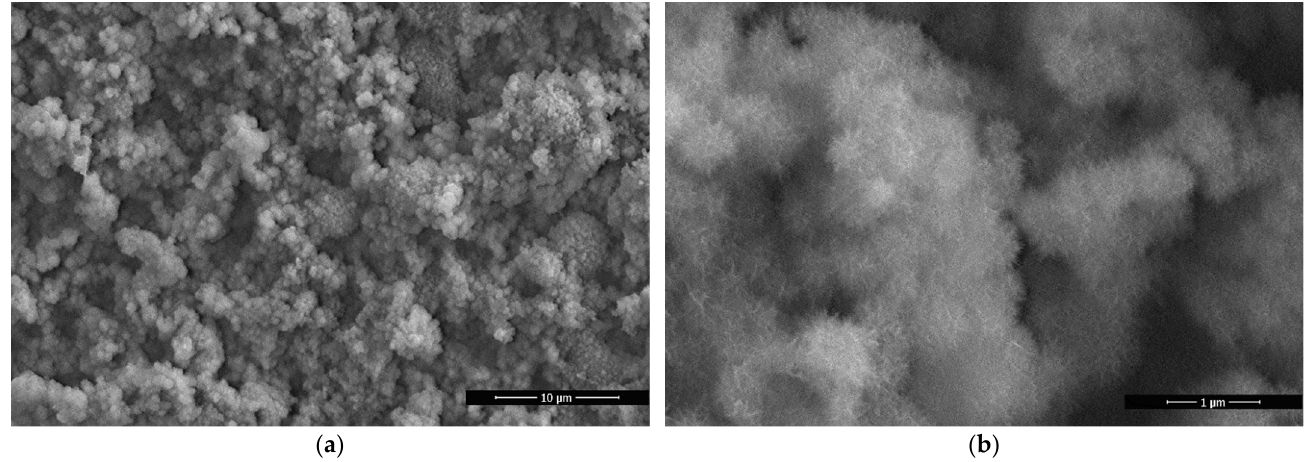
Figure 2. SEM images of the textured aluminum surface modified with poly-(HBMA-co-GMA): ( а ) 8000×; ( b ) 60,000×.